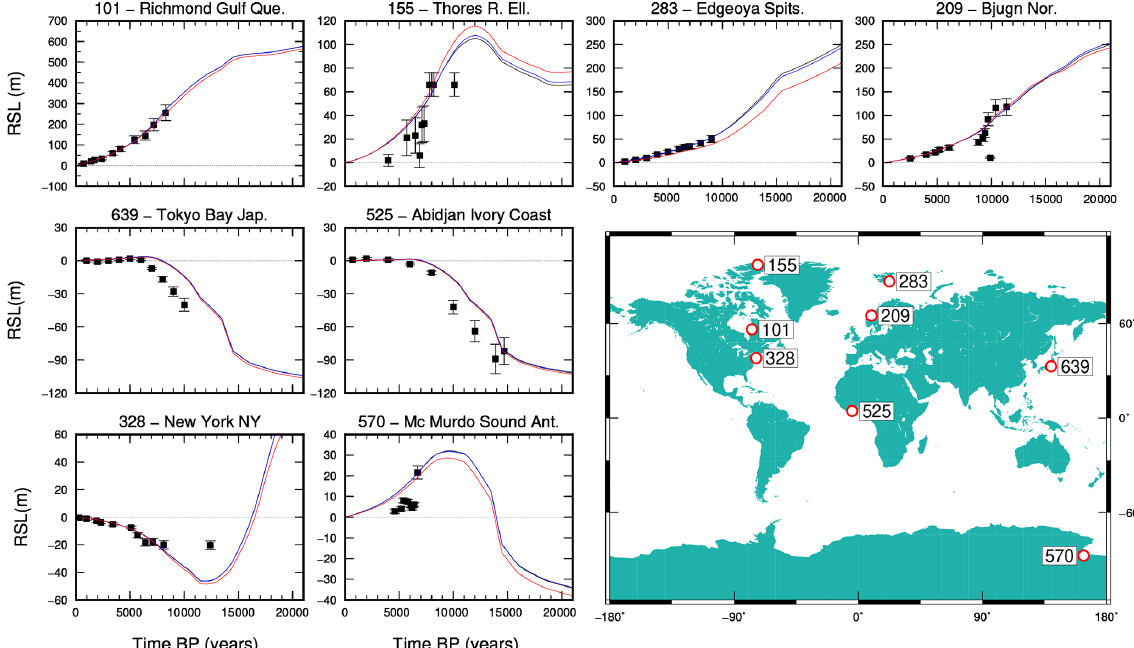
Figure 4. RSL data (with error bars) at eight of the 392 sites of the TP93 RSL database. Black curves show the results of the standard test run with configuration R44/L128/I3 , the blue ones are for the high-resolution run with R100/L512/I5 , while those in red are for a low-resolution configuration with R30/L64/I2 . The map shows the location of the RSL